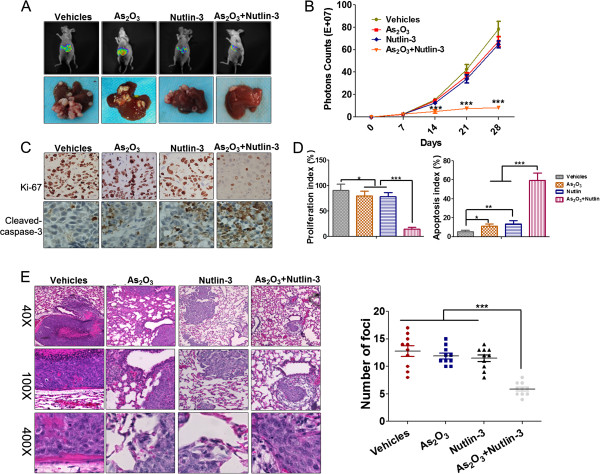
Nutlin-3 potentiates the anti-tumor effects of arsenic trioxide in vivo. (A) Representative bioluminescence images corresponding to the SMMC7721/As orthotopic hepatic tumors formed in the liver of the nude mice. (B) Volume of SMMC7721/As orthotopic tumors was determined at different time points. Data points represent the mean ± SD. (***P < 0.001, two-way ANOVA with Bonferroni post-test). (C) Representative images of sections stained with anti-Ki-67 antibody, or with anti-cleaved caspase-3 antibody. (D) Cells expressing Ki-67 were counted to calculate the proliferation index; cleaved caspase-3-positive cells were counted to give the apoptosis index. (*P < 0.05, **P < 0.01, ***P < 0.001, two-way ANOVA with Bonferroni post-test). (E) The representative H&E staining of pulmonary metastasis (arrows) on 5wk (left panel) and the average number of foci per mouse were calculated (right panel); (***P < 0.001, two-way ANOVA with Bonferroni post-test).